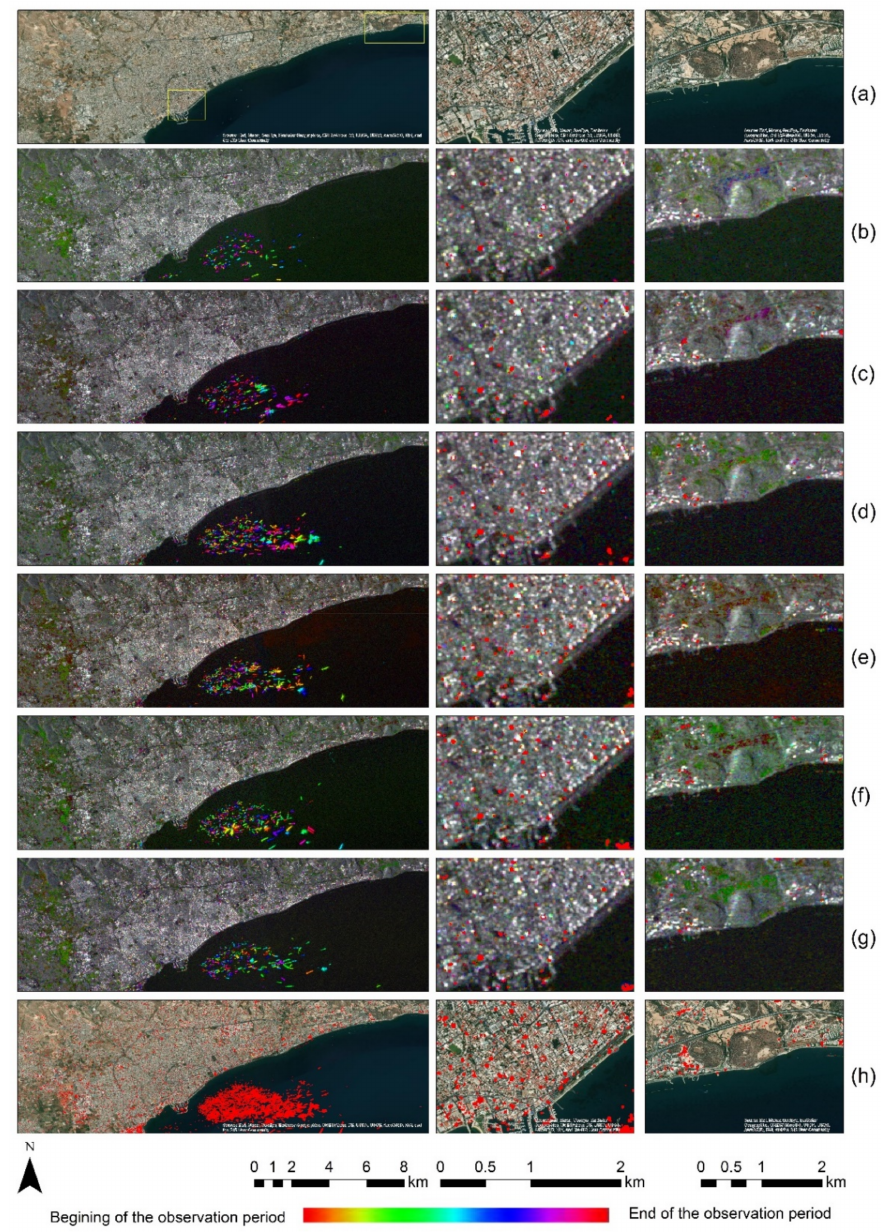
Figure 5. ( a ) High-resolution optical satellite image over the broader area of Limassol (left), city centre of Limassol (middle) and the Amathus archaeological site (right); ( b ) change detection analysis for the year 2015; ( c ) change detection analysis for the year 2016; ( d ) change detection analysis for the year 2017; ( e ) change detection analysis for the year 2018; ( f ) change detection analysis for the year 2019; and ( g ) change detection analysis for the year 2020. The cumulative changes for all years between 2015 and 2020 are shown in ( h ). At the bottom of the figure, a colour ramp indicates the relation of the colour according to the observation period for each